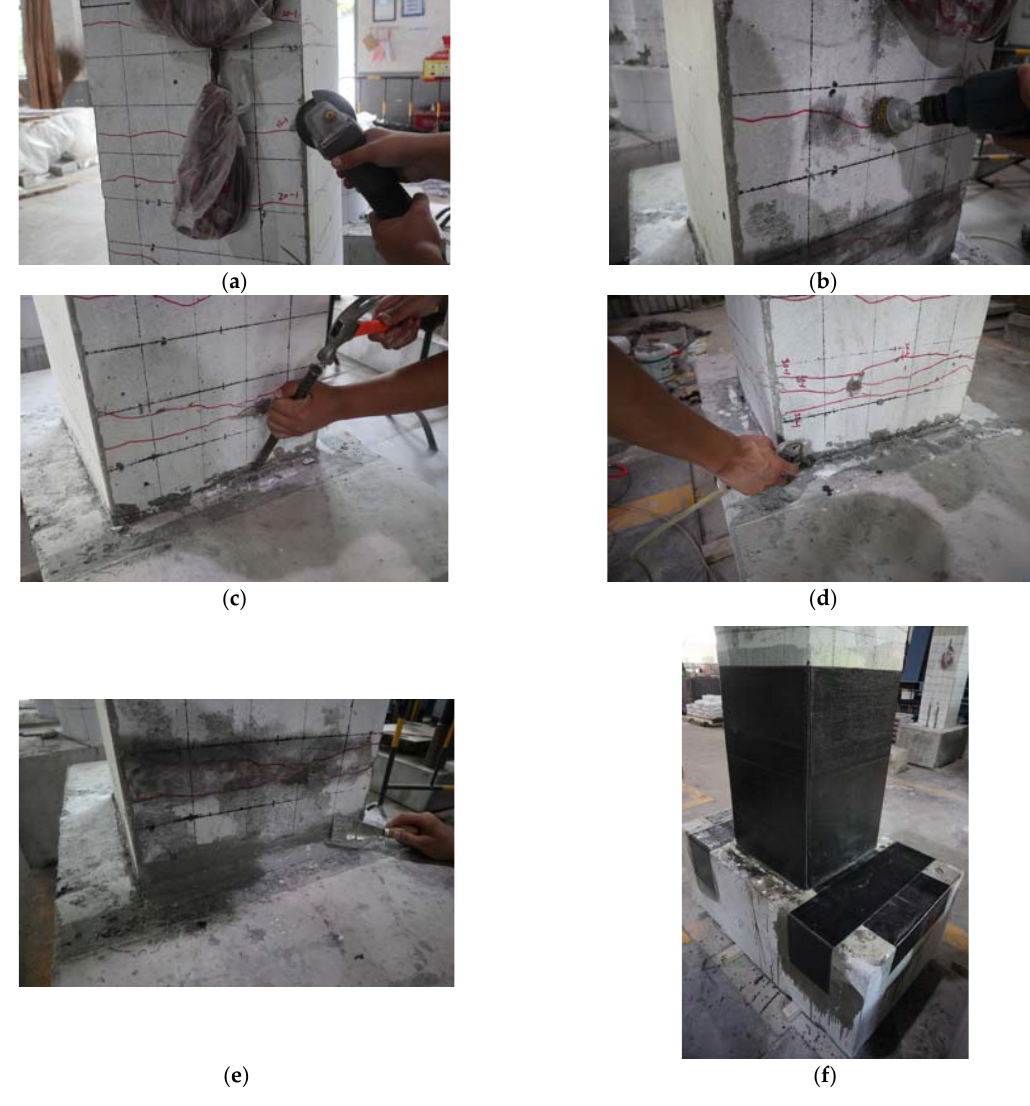
Figure 4. Repair procedures: ( a ) rounding the corner; ( b ) roughing the surface; ( c ) removing the spalling concrete; ( d ) cleaning the surface; ( e ) filling the crack and the corner of the column–footing interface; ( f ) applying the CFRP fabrics.